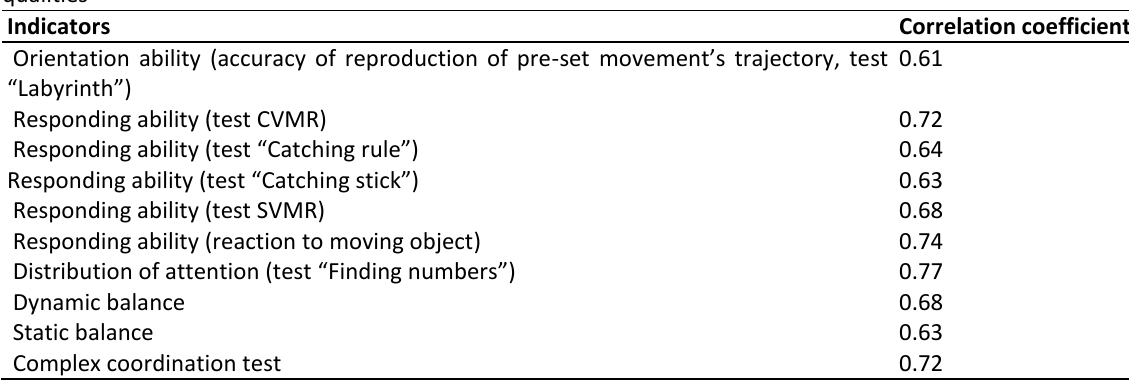
Table 1. Correlations of indicator, reflecting attention, operative memory, quickness of memorizing and accuracy of the received information reproduction with indicators of orientation, responding and kinesthetic